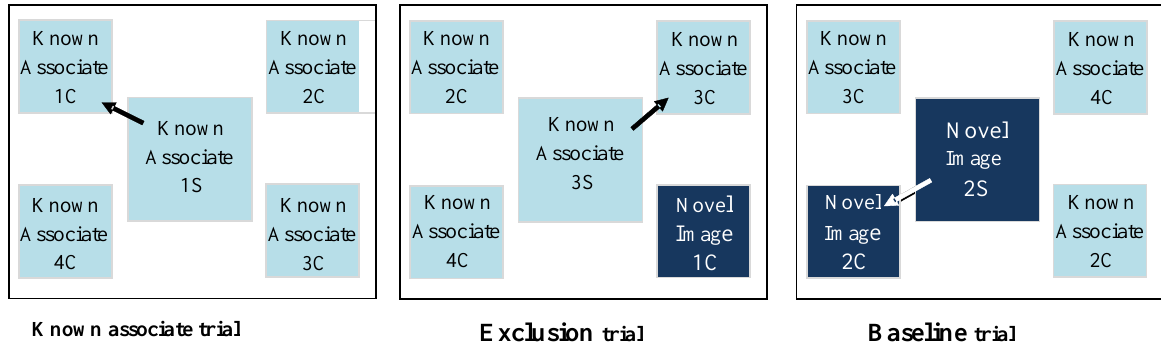
Figure 2 . The three trial types presented in Experiment 1. The center sample image (“S”) appeared first. Once it was touched, the four comparison images (“C”) appeared in the four corners of the screen. Arrows indicate the correct response. Dark boxes indicate novel images. Light boxes indicate trained known associate sample and comparison